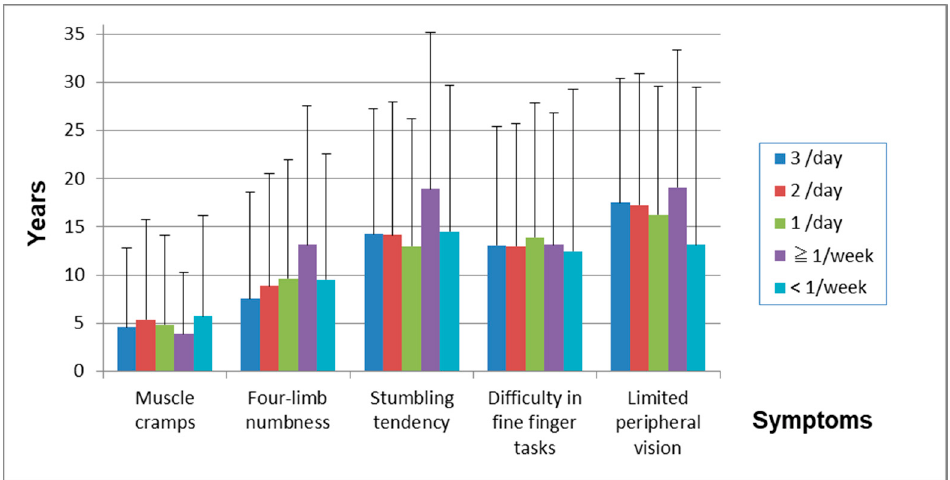
Figure 9. Onset of symptoms and frequency of fish ingestion. The time of onset of subsequent symptoms increased as the frequency of fish ingestion decreased.